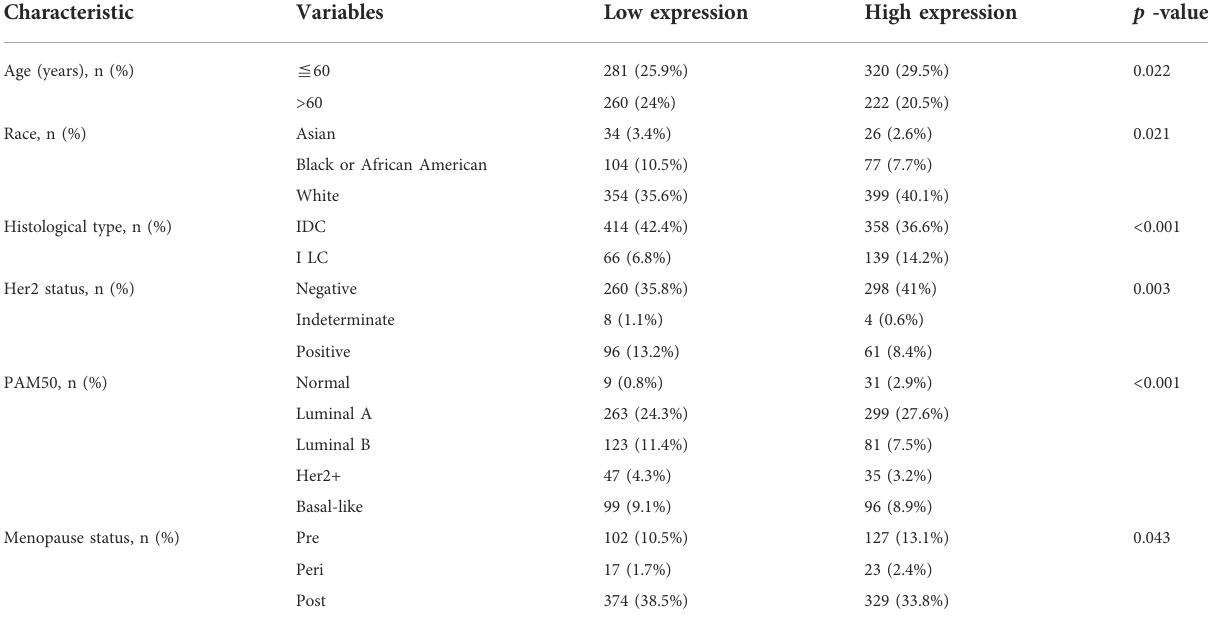
TABLE 3 The correlation of BTG1 mRNA expression with clinicopathological features of breast cancer.